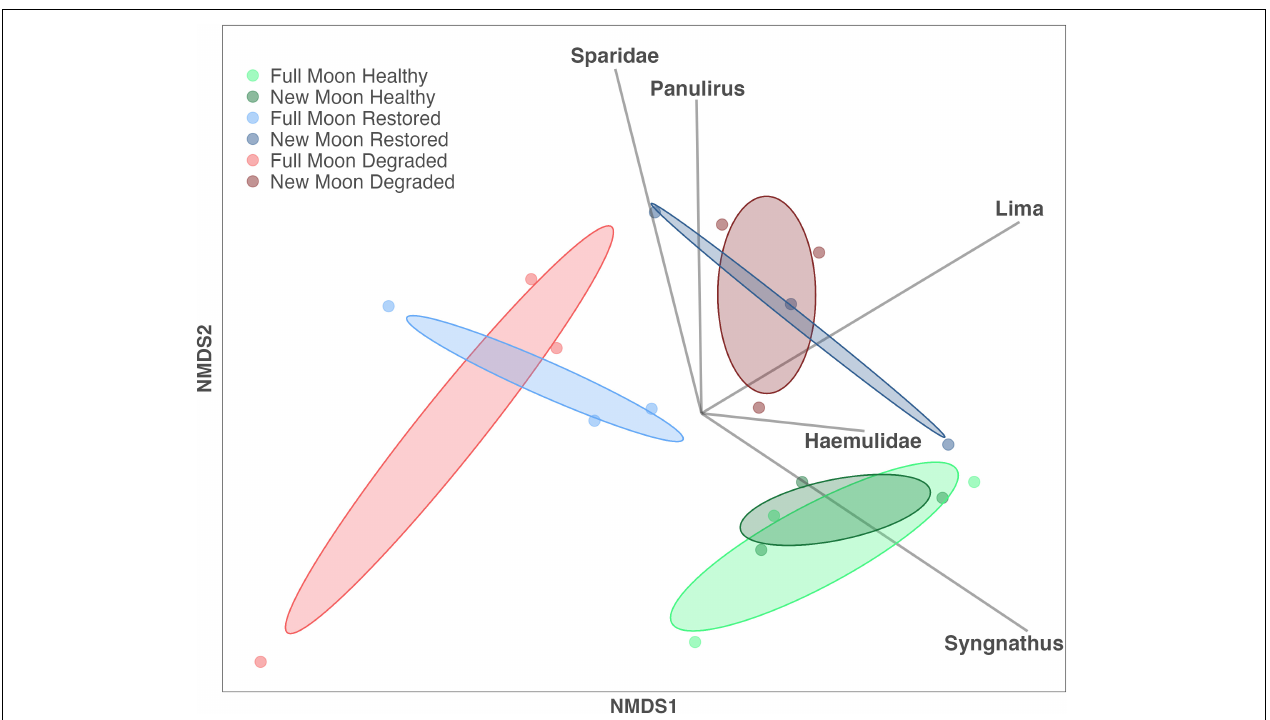
FIGURE 3 | Two-dimensional non-metric multidimensional scaling plot showing groupings of healthy, restored, and degraded hardbottom sites. Healthy hardbottom is displayed in green, restored hardbottom is displayed in blue, and degraded hardbottom is displayed in red. Darker color shades indicate new moon and lighter color shades indicate full moon. Overlapping ellipsoids indicate similarity between groups, and species vectors indicate the top five species that influenced the